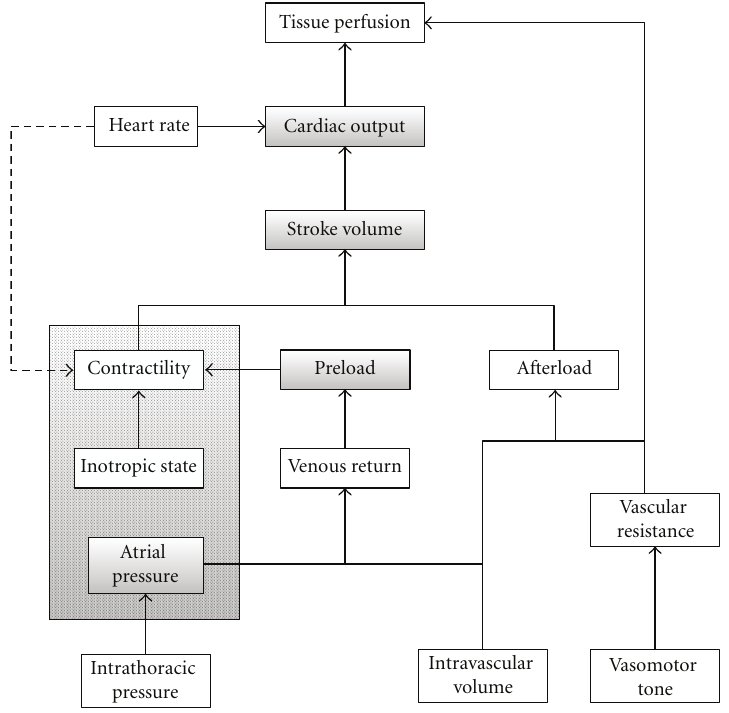
Figure 1: General scheme of